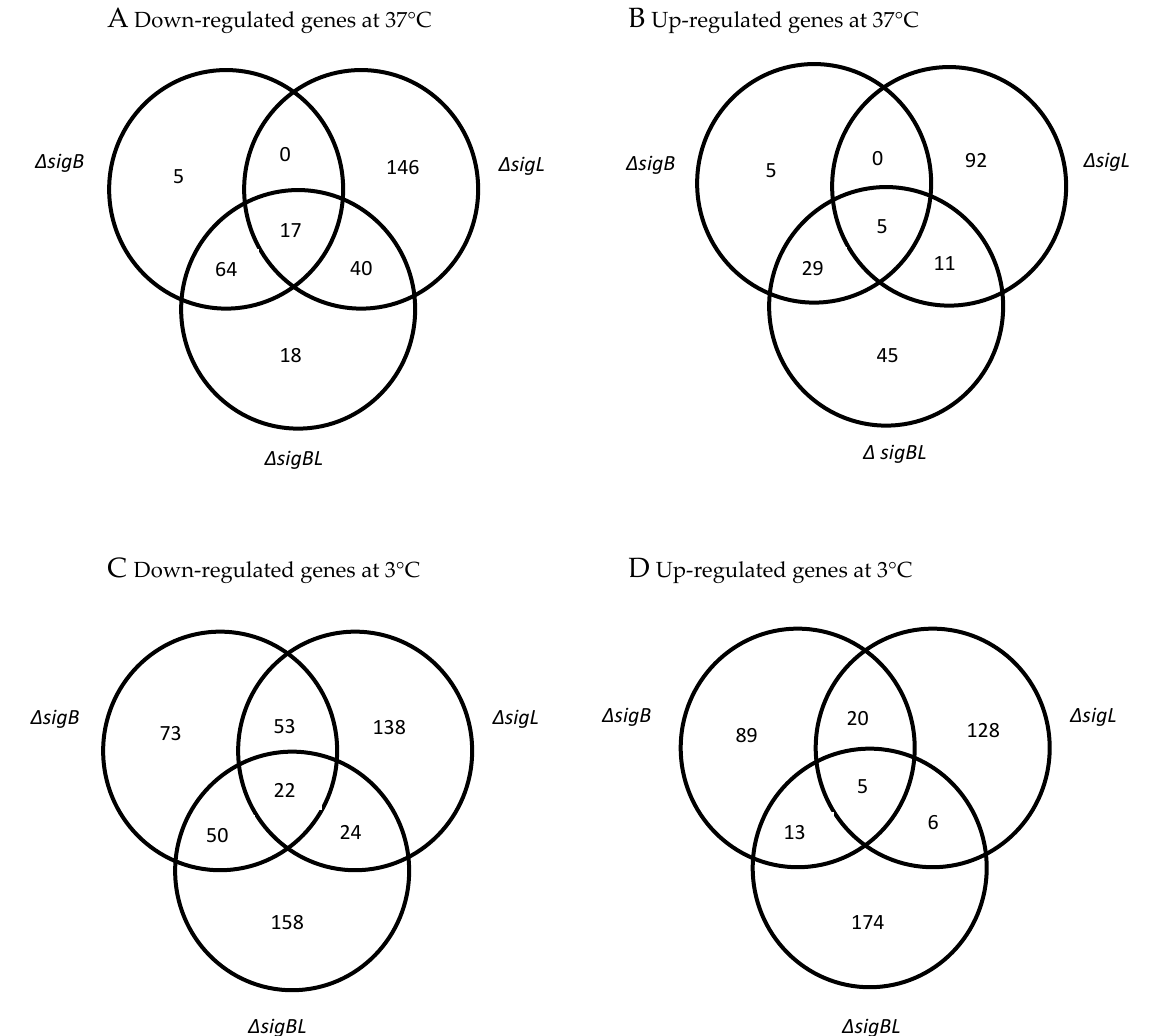
Figure 1. Overview of down- and up-regulated genes in Listeria monocytogenes ∆ sigB , ∆ sigL [36] and ∆ sigBL compared to the wild-type EGD-e strain detected during exponential growth in BHI at 37 ◦ ( A ) and ( B ) and 3 ◦ C ( C ) and ( D ). Genes showing 2.5-fold change ( p -value ≤ 0.01) in transcript abundance were considered di ff erentially expressed.